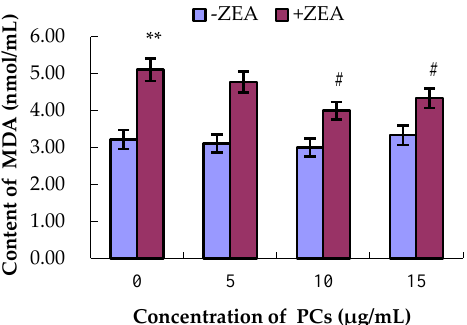
Figure 8. Effects of different concentrations of proanthocyanidins (PCs) on the content of malondialdehyde (MDA) exposed to zearalenone (ZEA) ( 65 μmol/L ). Content of MDA significantly increased when cells were exposed to ZEA, while the content of MDA did not increase when cells were treated with PCs. The content of MDA decreased when the cells were co-treated with PCs/ZEA. ** p < 0.01 vs. control group; # p < 0.05 vs. ZEA-treated group.